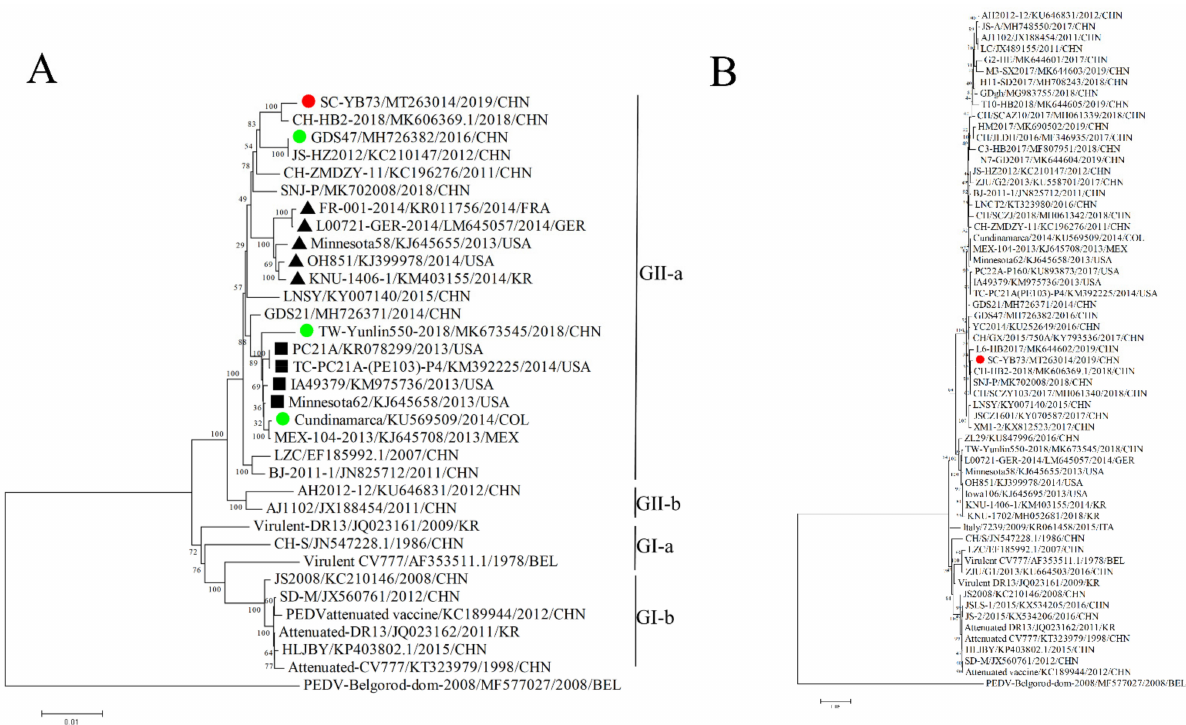
Figure 4. Phylogenetic analyses of complete sequence ( A ) and spike sequence ( B ) regions of SC-YB73 and most closely related strains in GenBank for which whole genome sequences were available. Neighbor joining was used for the construction of the phylogenetic tree with 1000 bootstrap replicates shown at branches. Scale bar represents p -distance. Red circle represents isolated strain in this study. Green circles represent possible recombinant strains. Black triangles represent US-PEDV-S-INDEL- variant-like strains. Black squares represent US PEDV prototype-like strains. CHN, China; USA, United States of America; GER, Germany; BEL, Belgium; COL, Columbia; KR, Republic of Korea; MEX, Mexico; FRA, France; ITA,